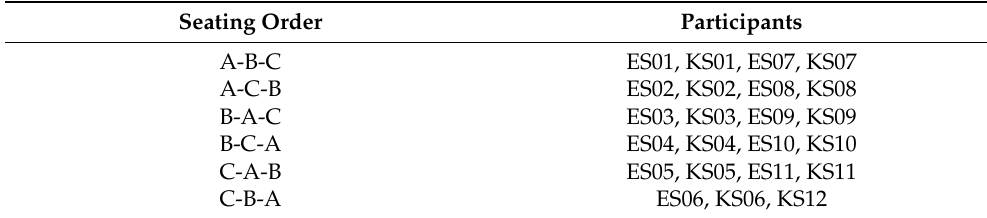
Table 2. Seating order for participants with ADHD (ES) and without ADHD (KS). The seats are marked as A—active seat, B—therapy ball and C—school